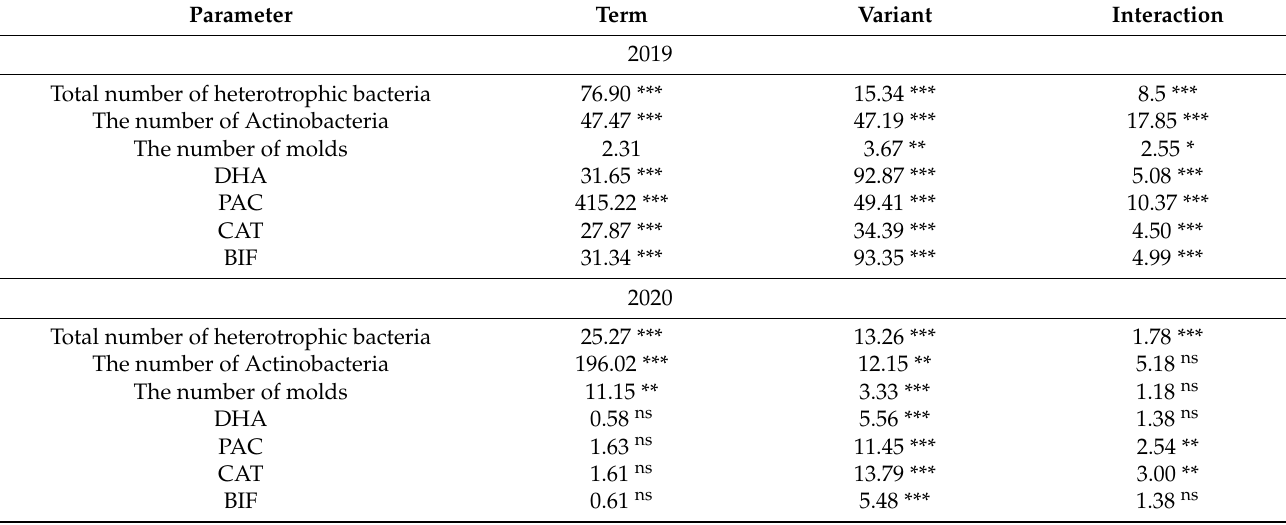
Table 2. The F test statistics and significance levels of the two-way ANOVA for the counts of selected groups of microorganisms and enzyme activity resulting from the applied catch crop and/or applied bacterial consortium and the date of test as differentiating